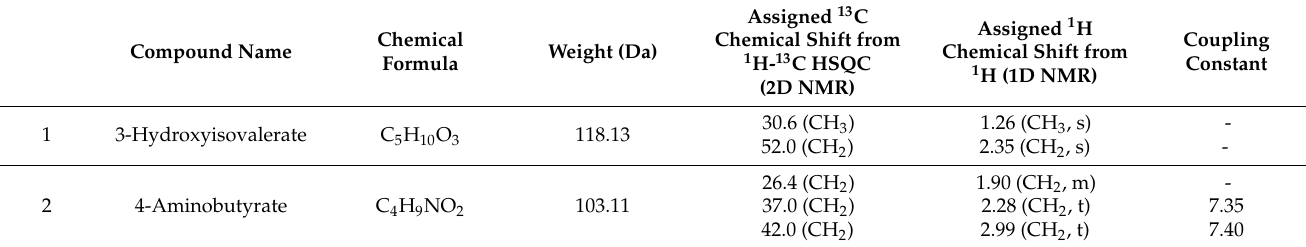
Figure 5. 1D 1 H NMR spectra of Subramaniula asteroids polar extract. ( A ) Aliphatic region, ( B ) sugar abundance signals region, and ( C ) aromatic region. Table 1. The identified metabolites in the polar extract of Subramaniula asteroids